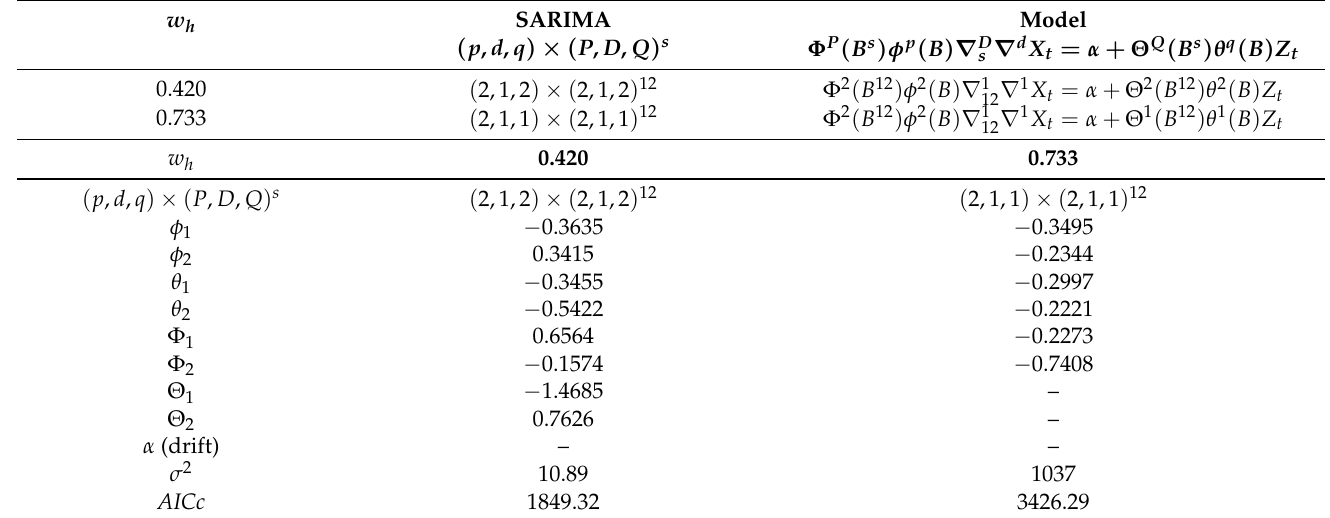
Table A3. ( Top ) H-to-M transmission efficiency ( w h ) levels from model simulations and in relation to the SARIMA models ( α = drift). ( Bottom ) Different H-to-M transmission efficiency levels ( w h = 0.420 and w h = 0.733), and coefficients of the SARIMA models.